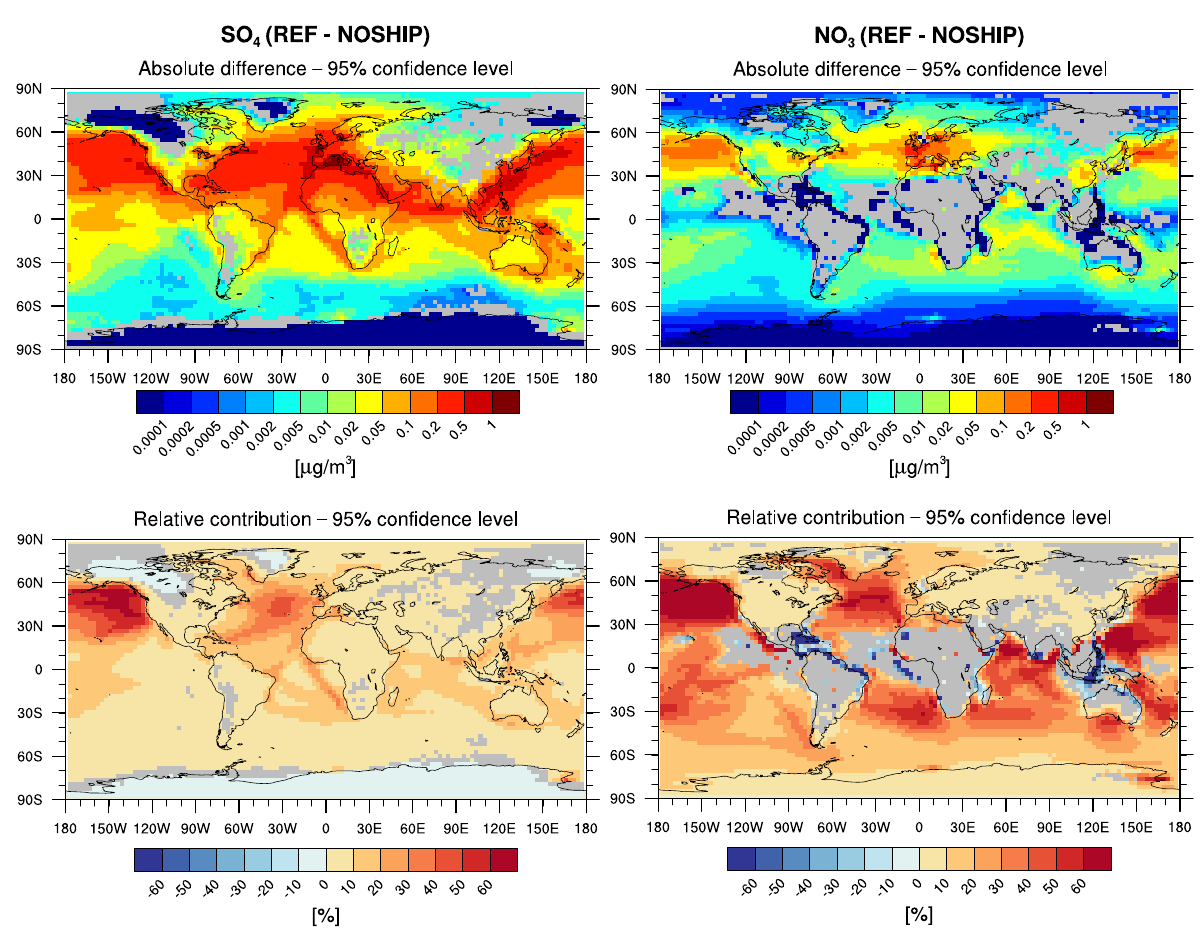
Fig. 5. Multi-year average (1996–2005) of the absolute (top) and the relative effect (bottom) of shipping on SO 4 (left) and aerosol nitrate (NO 3 , right) concentrations at the surface. Plotted are the differences between the experiments REF and NOSHIP. The relative effect is calculated as the relative contribution (REF–NOSHIP)/REF. Grid points where the difference is not statistically significant according to a uni-variate t test (5% error probability) are masked out in